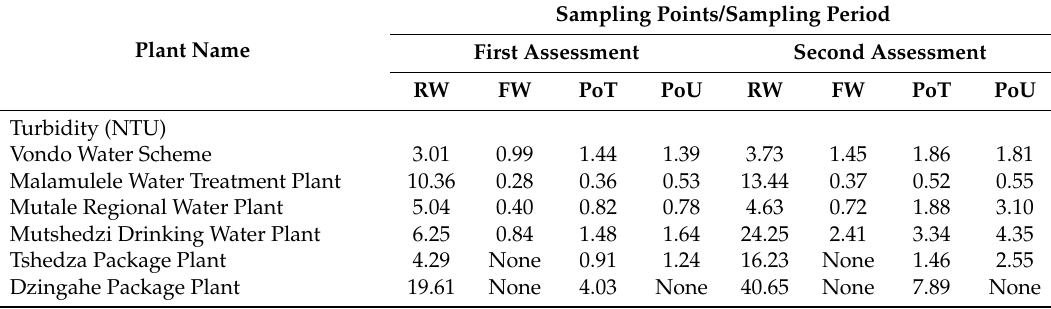
Table 4. Monitoring of turbidity (NTU) in selected plants.